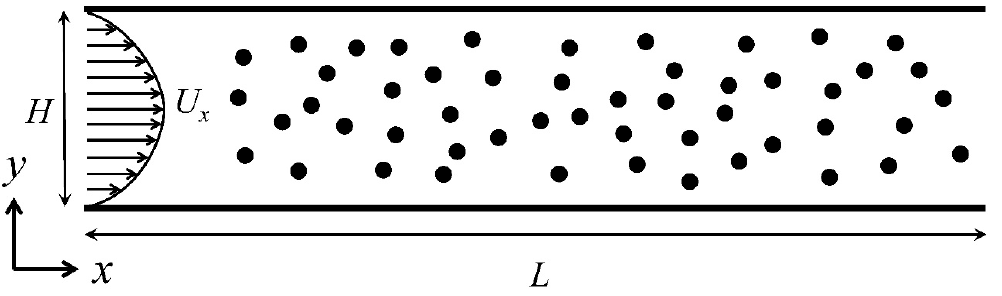
Figure 13. Schematic of pressure-driven flow of dense particle suspensions.